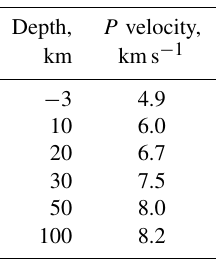
Table 2. The optimal 1-D P velocity distribution used as a reference model for the tomographic